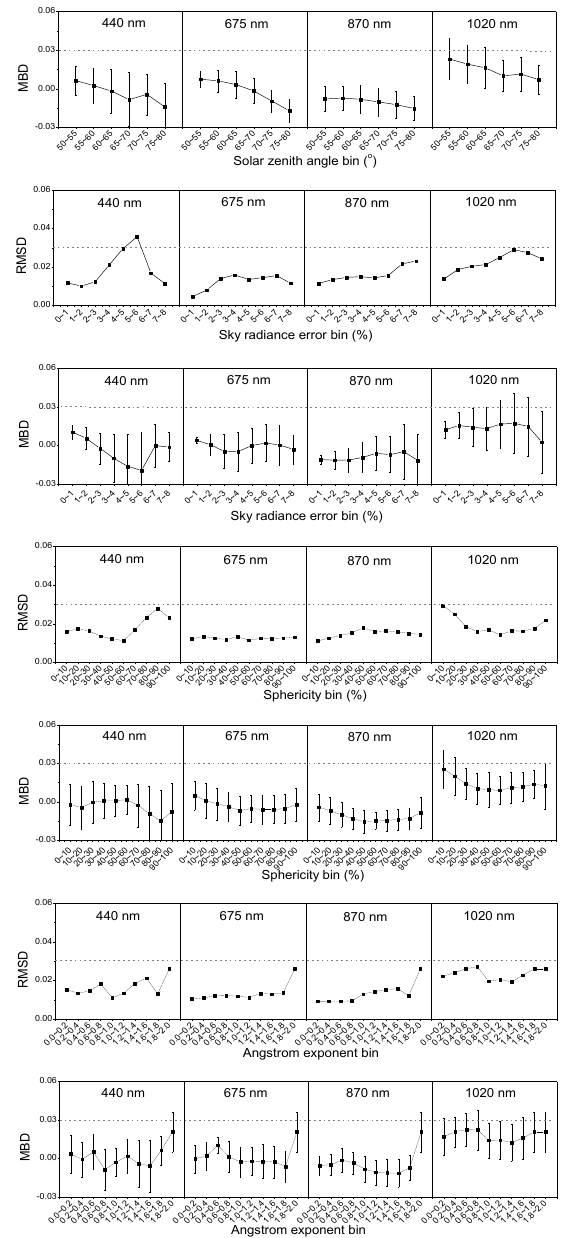
Figure 2 SSAs deviations (RMSD, MBD and STD) of DVL and AERONET as a function of AOD (440 nm), SZ, Sky error, Sphericity and Ǻngström exponent, at 4 wavelengths of 440, 675, 870 and 1020 nm,